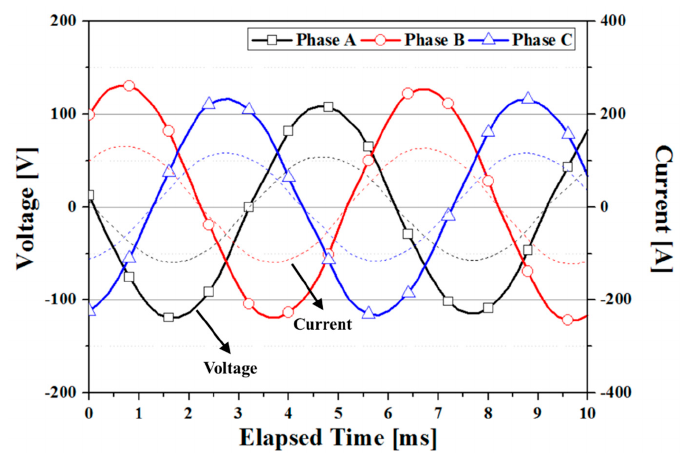
Figure 16. Phase voltage and line current in resistance-load condition due only to the NI HTS field coil.